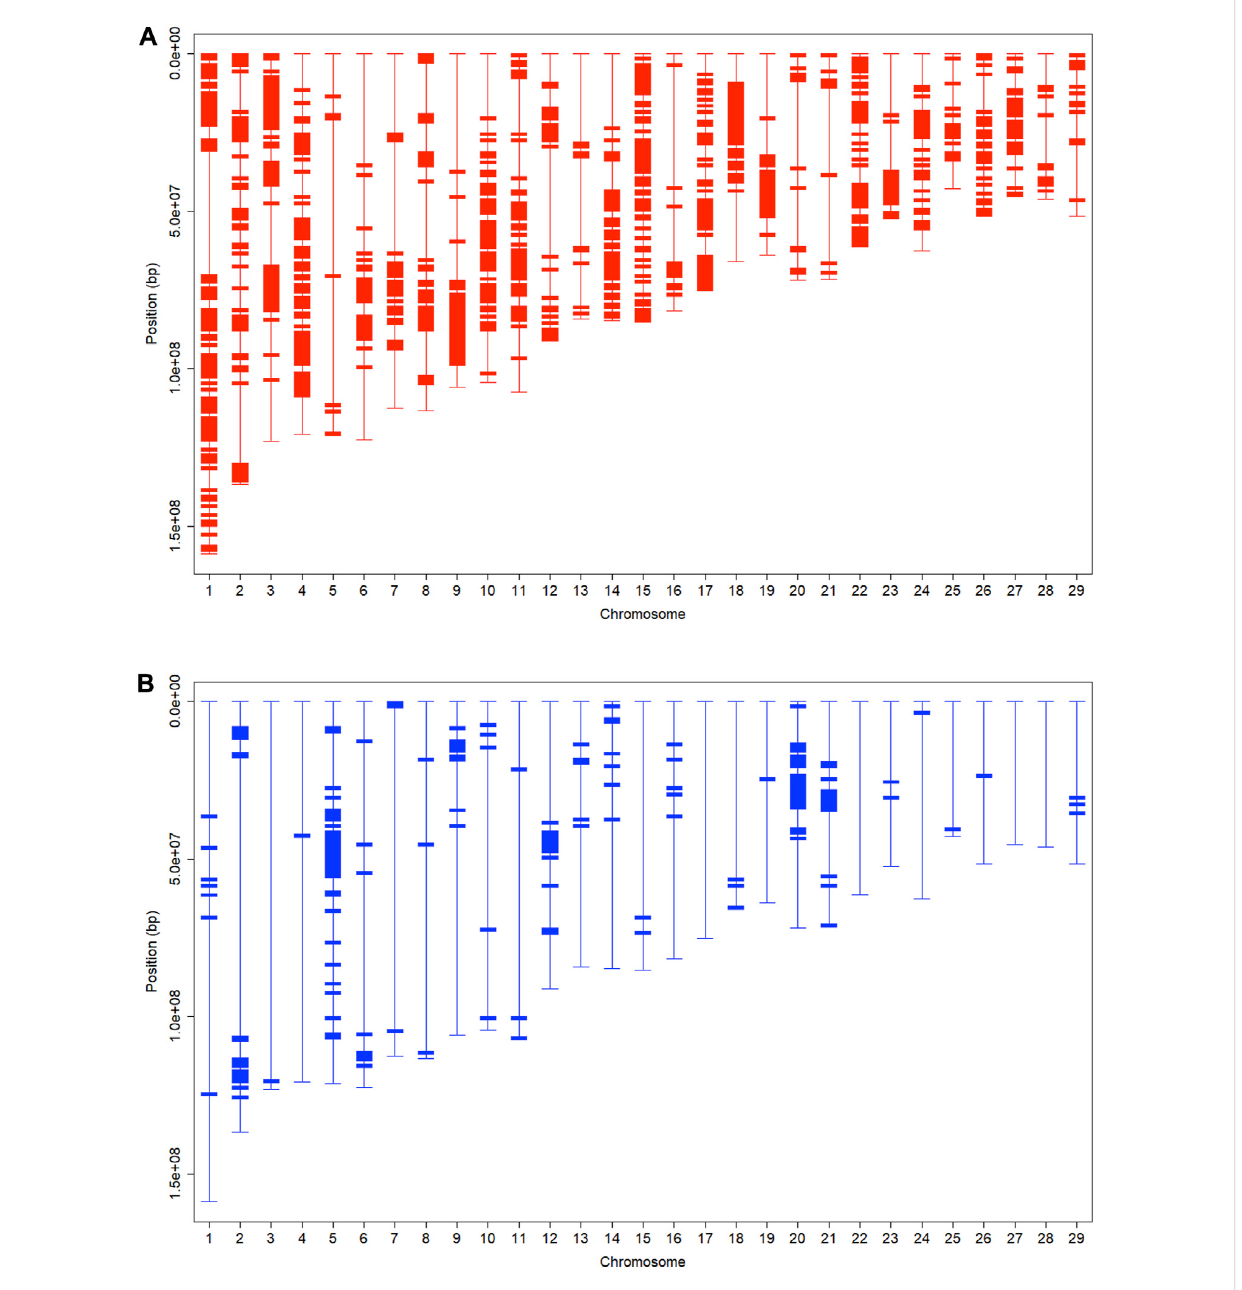
FIGURE 4 Chromosomal fragments with: (A) high ( ≥ 75%) Angus breed proportion (upper), and (B) high ( ≥ 50%) Brahman breed proportions (bottom), evaluated with a 1 Mb window size on 29 chromosomes in 3,605 Brangus cattle.